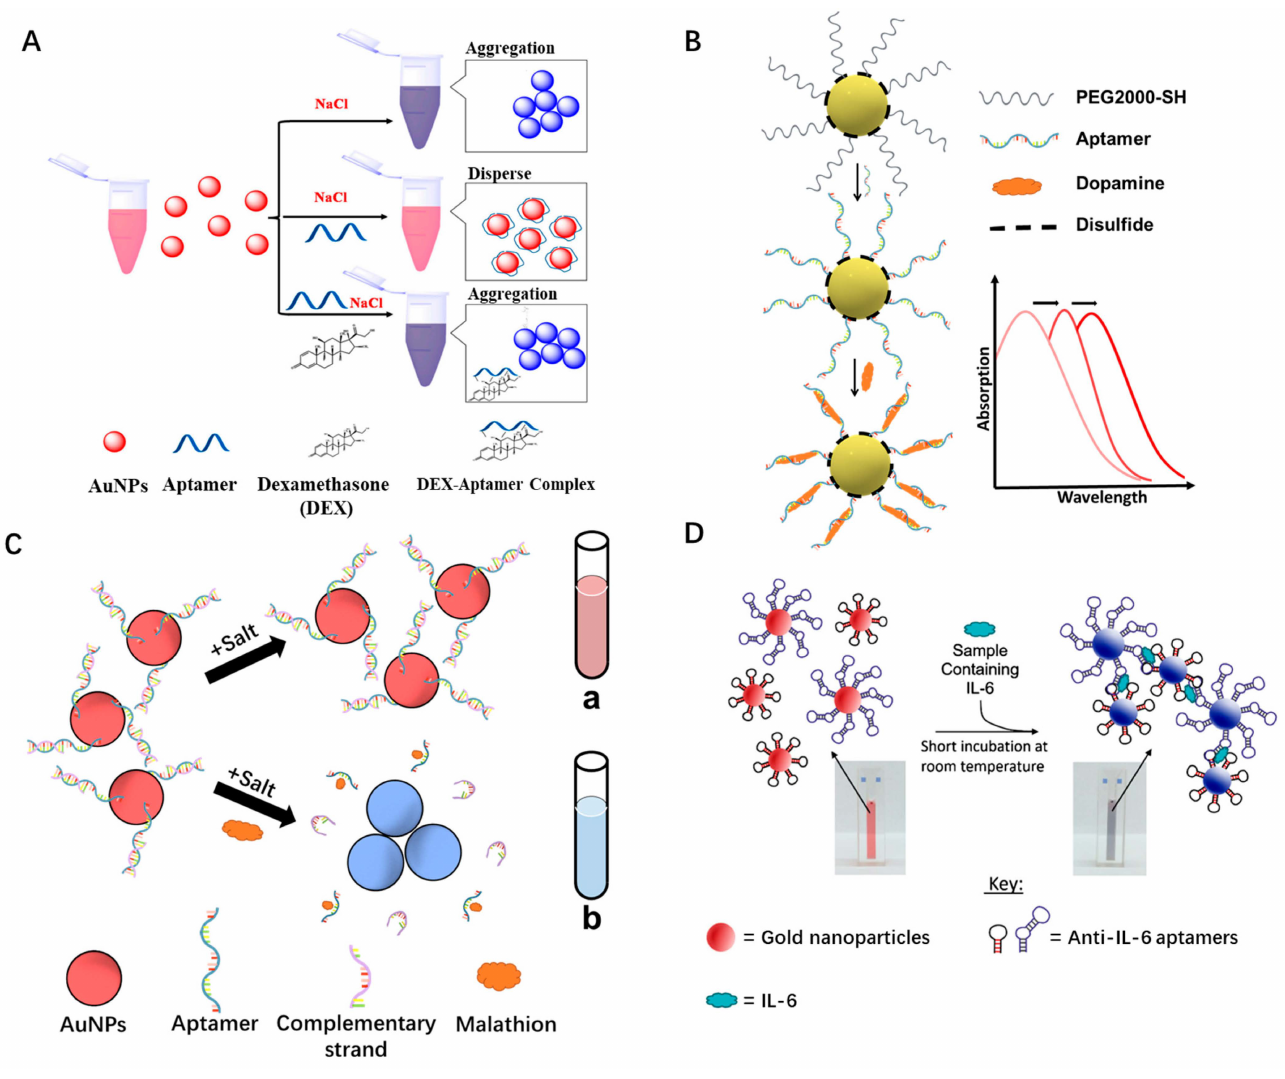
Figure 3. Colorimetric aptasensors based on AuNPs. ( A ) Schematic diagram of the colorimetric method for DEX detection, reproduced with permission from [37]. Copyright 2022